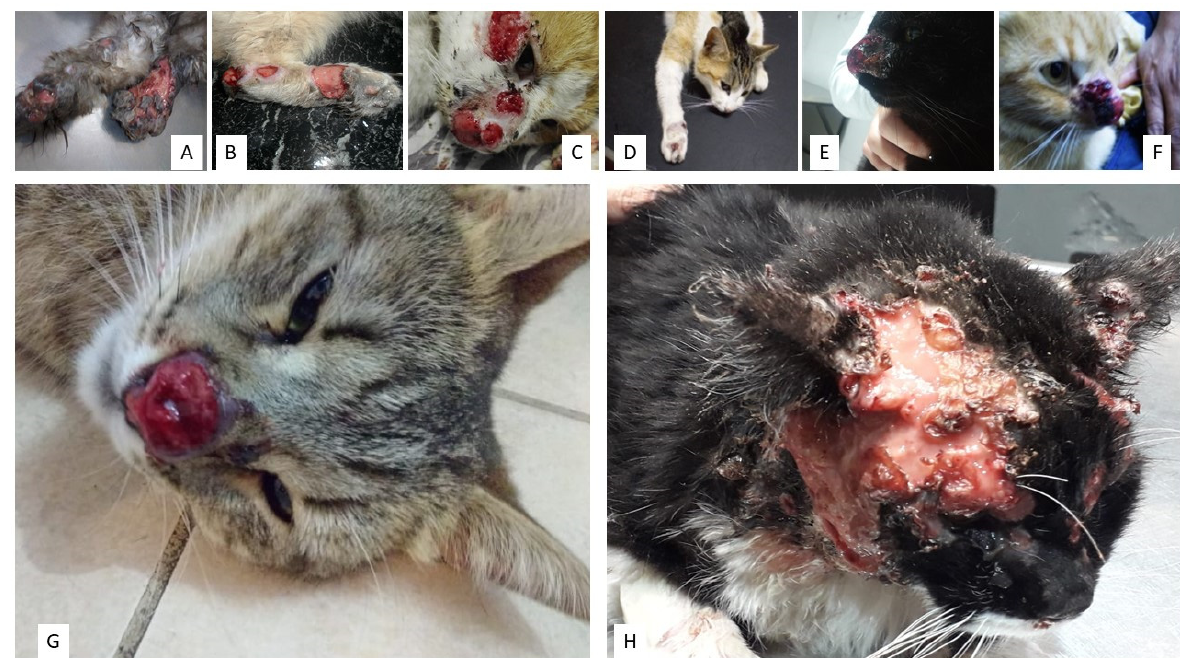
Figure 4. Feline sporotrichosis. ( A ) Multiple ulcerative crusted lesions around the claws. ( B ) Multiple ulcerative crusted lesions on the hind limbs. ( C ) Ulcerative crusted facial lesions. ( D ) Ulcerative lesion on the forelimbs. ( E – G ) (Multiple) ulcerative crusted lesion on the nose. ( H ) Multiple ulcerative crusted lesions on the head.